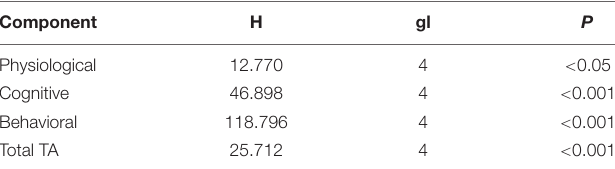
TABLE 6 | Difference in test anxiety components and total TA according to academic